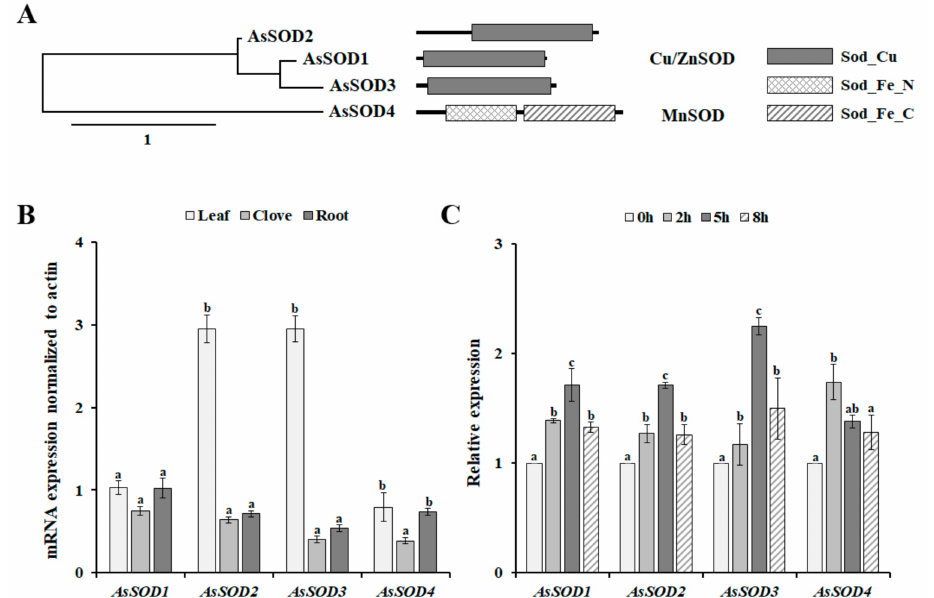
Figure 2. Phylogenetic tree, domain architectures ( A ), and expression patterns of putative garlic SODs ( AsSODs ) in different organs ( B ) and in response to heat stress ( C ). Scale bar in phylogenetic tree represents distance scale. For organ-specific expression analysis, the expression level of each gene was normalized relative to actin, whereas the normalized expression levels of AsSODs were expressed relative to their value at 0 h for analysis of the heat-induced expression pattern. The bars represent the mean ± SE across five independent experiments. Different letters indicate statistically significant differences ( p <